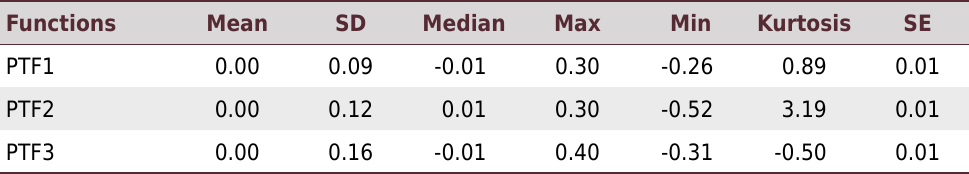
Table 3. Descriptive statistics of residual values of